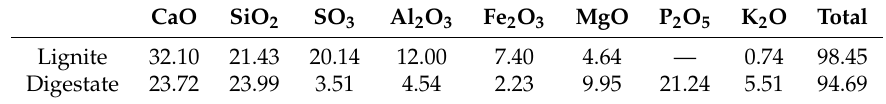
Table 6. X-ray fluorescence (XRF) analysis of the ash components of lignite and digestate (wt%). CaO SiO 2 SO 3 Al 2 O 3 Fe 2 O 3 MgO P 2 O 5 K 2 O Total Lignite 32.10 21.43 20.14 12.00 7.40 4.64 — 0.74 98.45 Digestate 23.72 23.99 3.51 4.54 2.23 9.95 21.24 5.51